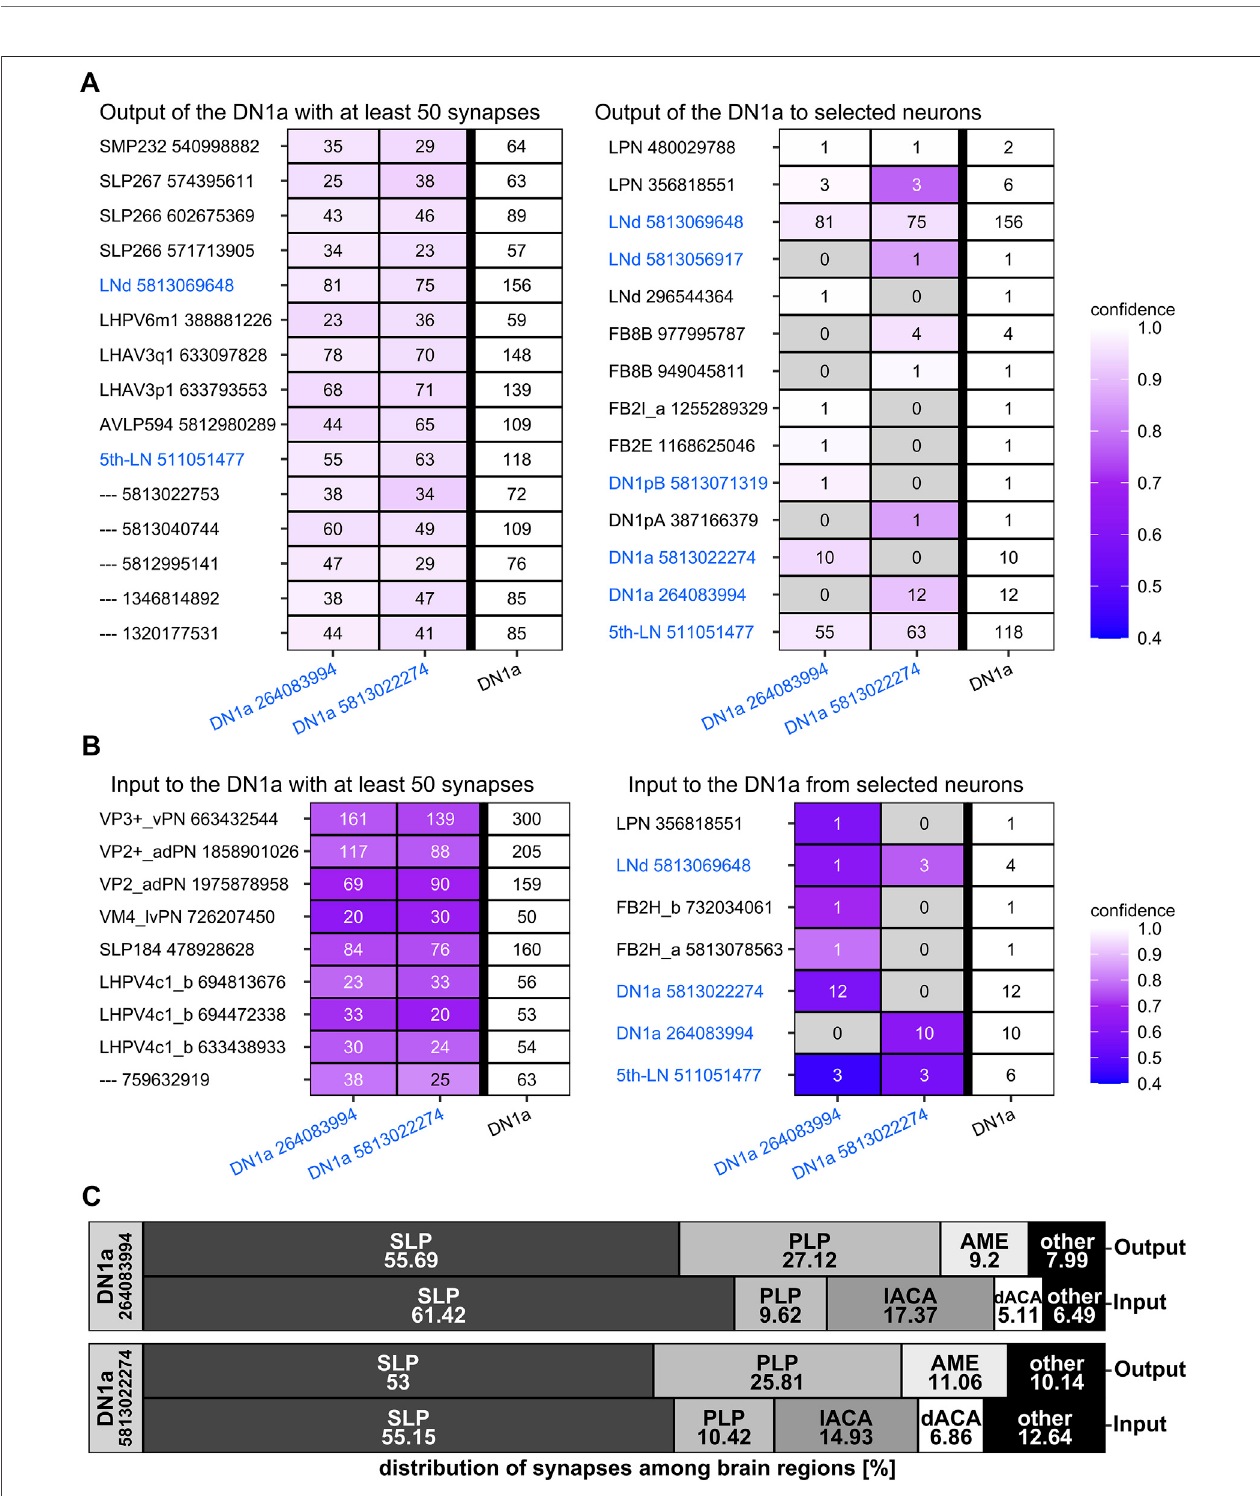
FIGURE 4 | Synaptic contacts of the two DN 1a s revealed from the hemibrain. (A) Postsynaptic partners of the two DN 1a s with at least 50 synapses (left panel) and output connections to selected partners such as the clock neurons and the fan-shaped body (FB) neurons (right panel). CRY-positive clock neurons are highlighted in blue. The DN 1a s give strong output to neurons with cell bodies located in the superior lateral protocerebrum (SLP) or the lateral horn (LH). Among these are the ITP positivelateral neurons(LN d and fi fthLN).Inaddition, thetwoDN 1a sformsynapseswitheachother,butthey haverelatively fewoutput synapsestotheotherclock neurons, including a neuron arborizing in the eighth layer of the FB. (B) Presynaptic partners of the two DN 1a s with at least 50 synapses and selected presynaptic partners. The DN 1a s get most input from temperature sensing projection neurons of the antennal lobes (VP3+_vPN, VP2+_adPN, VP2_adPN) and considerable input